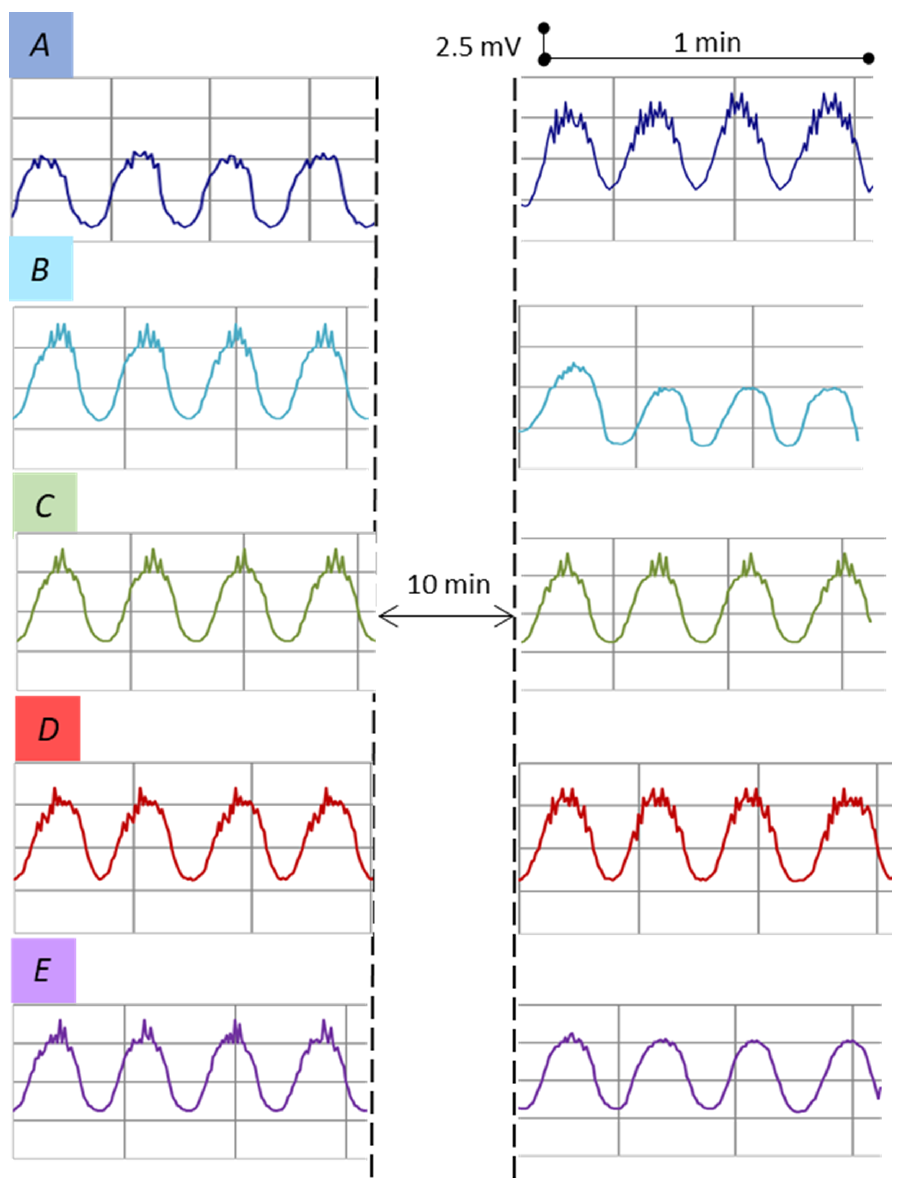
Figure 4. Experimental record of bioelectric activity of SM preparations, registered through sucrose gap method—control and 10 min after influence of 5 × 10 − 5 M 3 ( A ), 4a ( B ), 4b ( C ), 4c ( D ), 4d ( E ).